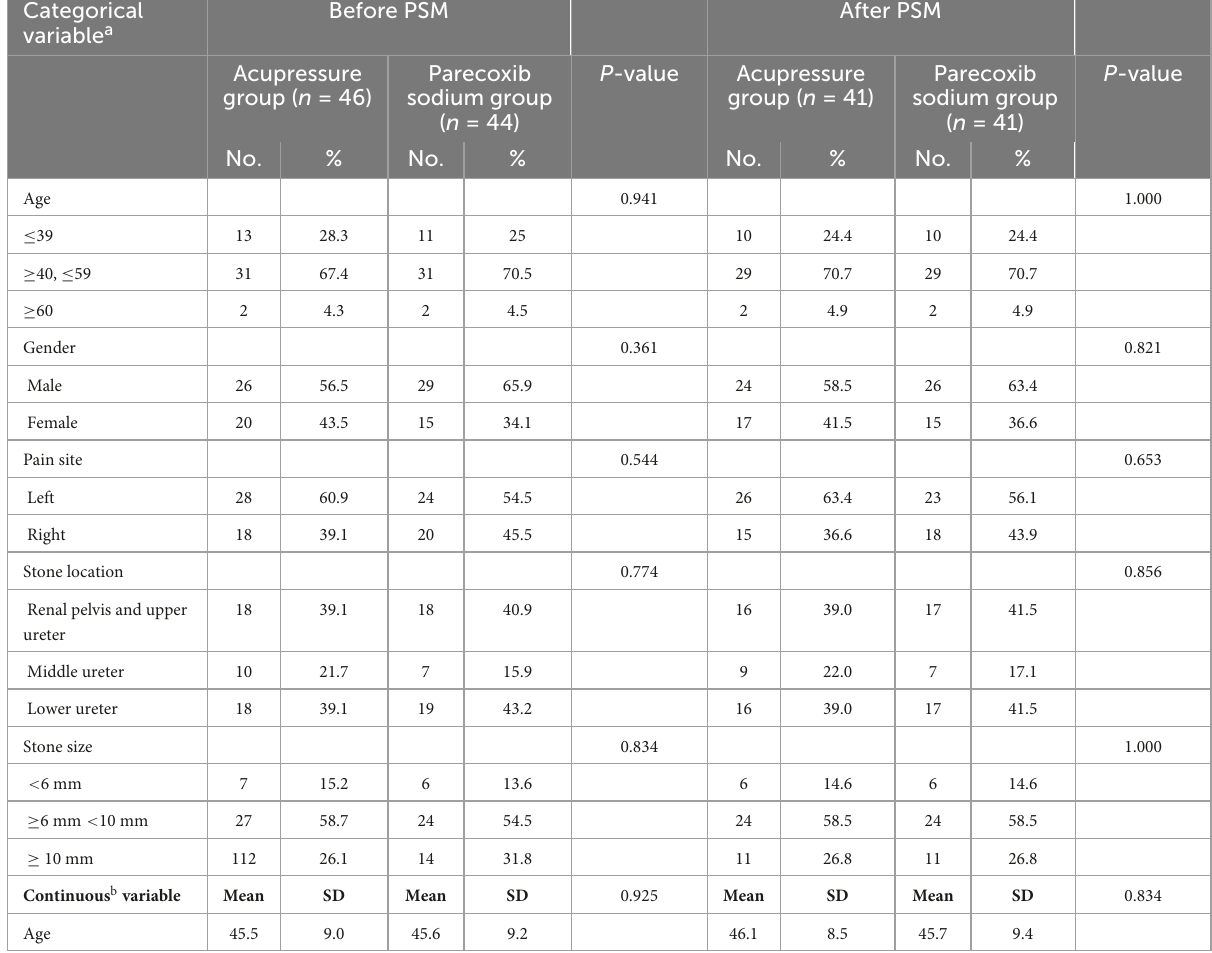
TABLE 1 Baseline demographic and clinical characteristics of enumeration data. Categorical variable